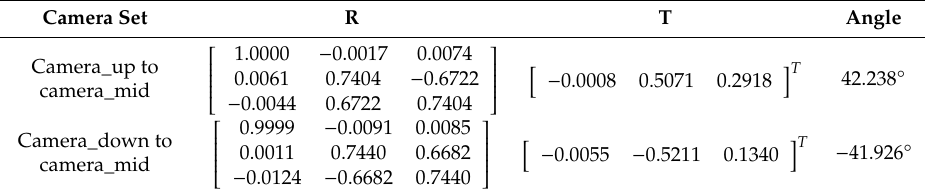
Table 3. External parameters between each